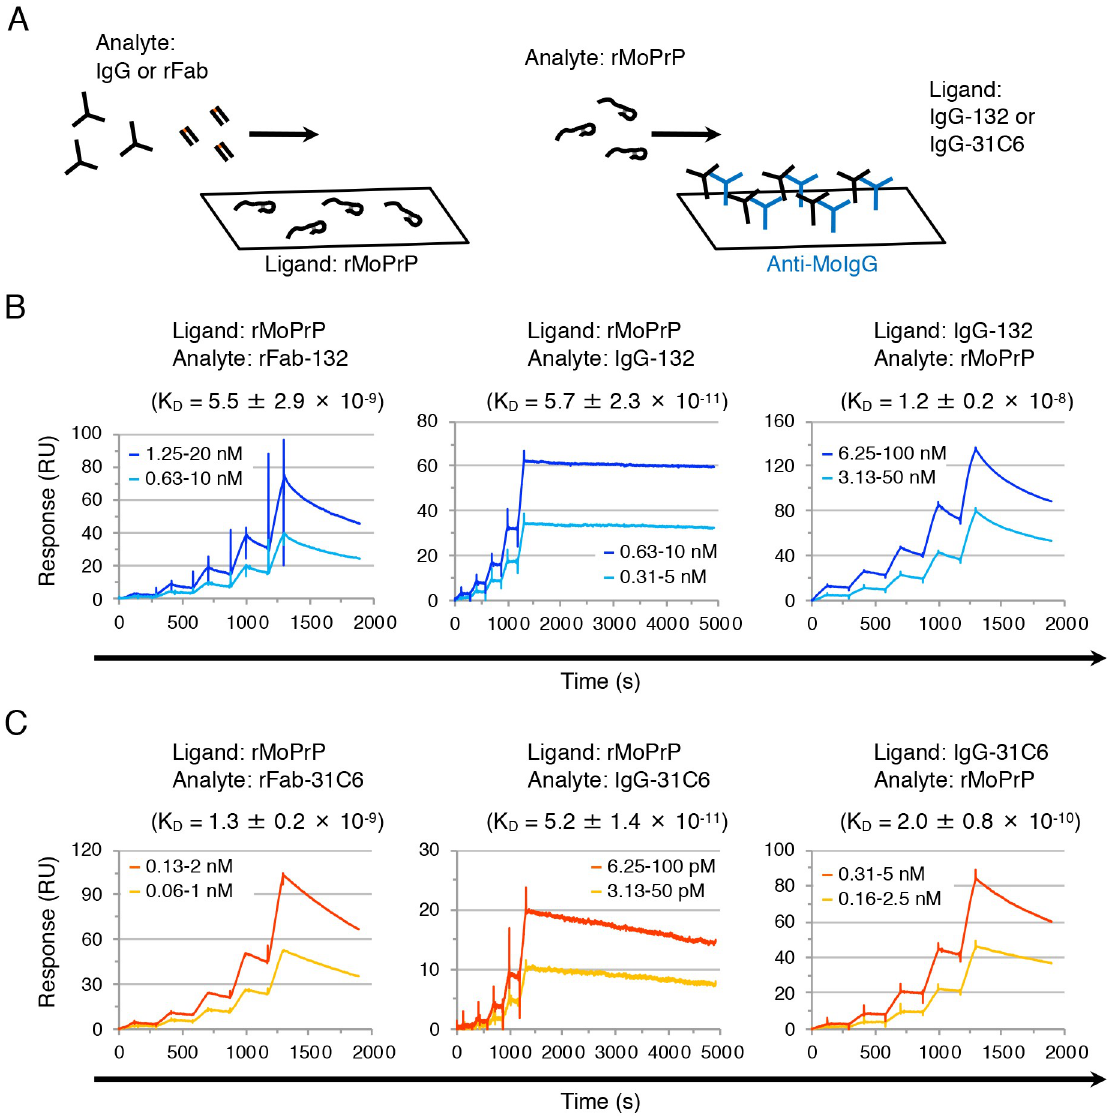
Fig 6. Binding affinity of mono- and bivalent authentic and recombinant antibody fragments. (A) Schematic illustrations for analytes and ligands. The SPR sensorgrams were measured using two different binding types: mono- or bivalent antibody fragments were injected to the sensorchip with immobilized rMoPrP (left), or rMoPrP was injected to the sensorchip with each IgG (at approximately 500 RU) captured by anti-MoIgG (blue) immobilized on the surface (right). (B) Representative sensorgrams for the binding of authentic and recombinant antibody fragments of mAb 132 to rMoPrP by single-cycle kinetics. All sensorgrams were obtained using 2-fold serial dilutions of antibodies or rMoPrP: rFab-132, 0.63–10 and 1.25–20 nM; IgG-132, 0.31–5 and 0.625–10 nM; and rMoPrP, 3.13–50 and 6.25–100 nM. The dissociation constant was calculated from three independent experiments (mean ± SD). (C) Representative sensorgrams for the binding of authentic and recombinant antibody fragments of mAb 31C6 to rMoPrP by single-cycle kinetics. All sensorgrams were obtained using 2-fold serial dilutions of antibodies or rMoPrP: rFab-31C6, 0.06–1 and 0.13–2 nM; IgG-31C6, 3.13–50 and 6.25–100 pM; and rMoPrP, 0.16–2.5 and 0.31–5